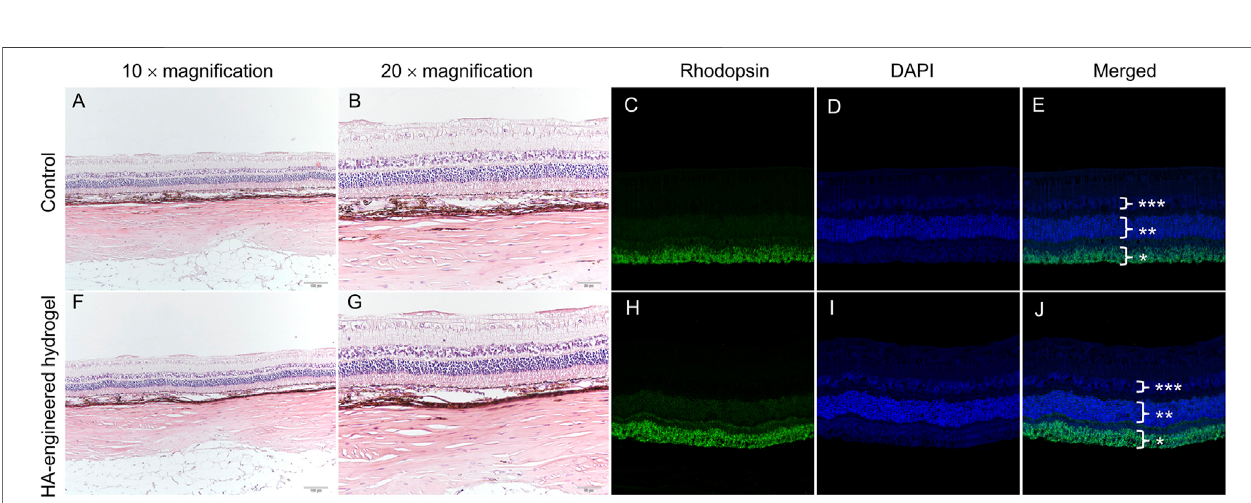
Frontiers in Bioengineering and Biotechnology |